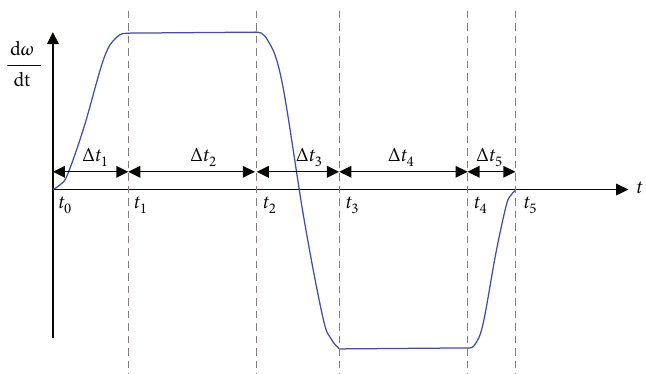
Figure 2: Modeling the acceleration for trajectory [14,